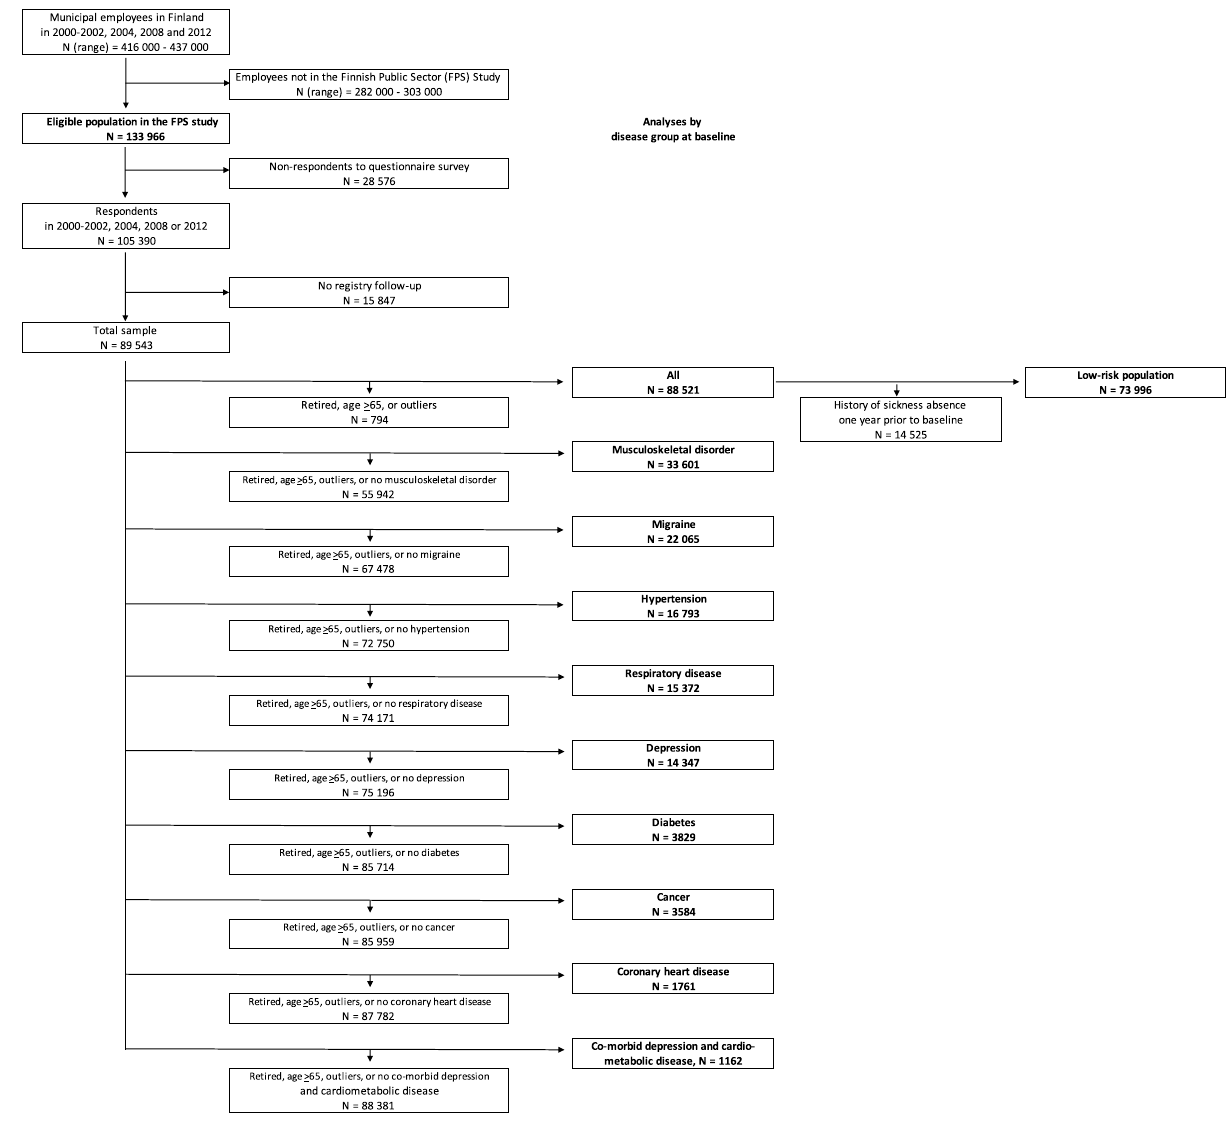
Figure 1. Flow diagram for total sample and disease